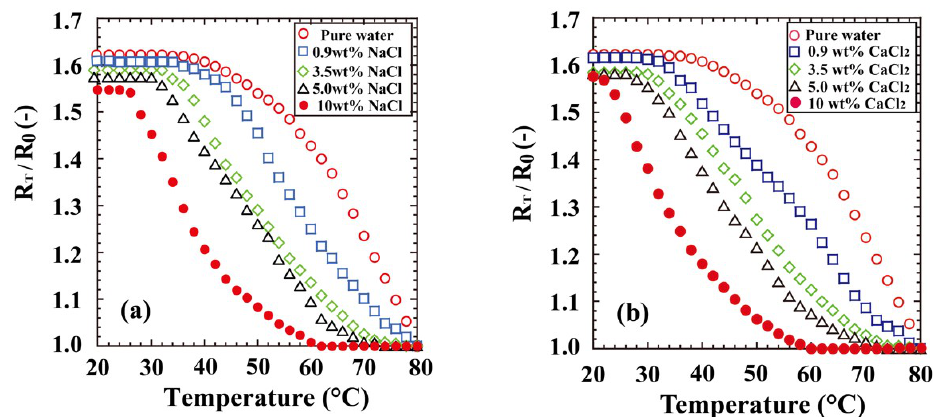
Figure 5. Transition behaviours of PTEGA gel in ( a ) aqueous NaCl and ( b ) CaCl 2 solutions.